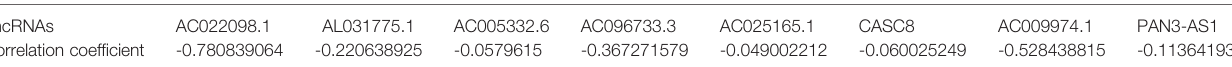
TABLE 1 | The 8 m5C-related lncRNA risk model